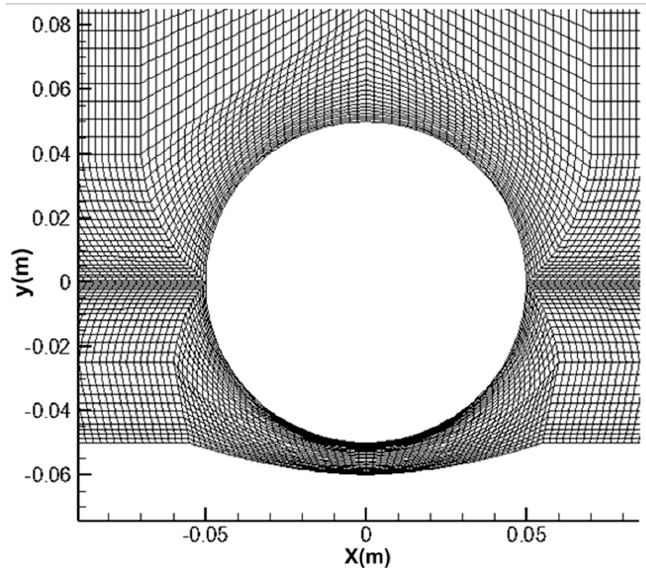
Figure 8. The mesh distribution around the pipeline in the scour test.